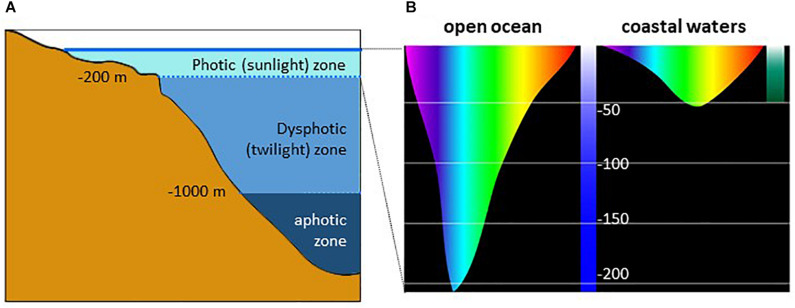
(A) Penetration of light into the water column and (B) illustration of the depth at which different colours of light penetrate ocean waters. (B is modified from the NOAA Office of Ocean Exploration and Research, with permission).